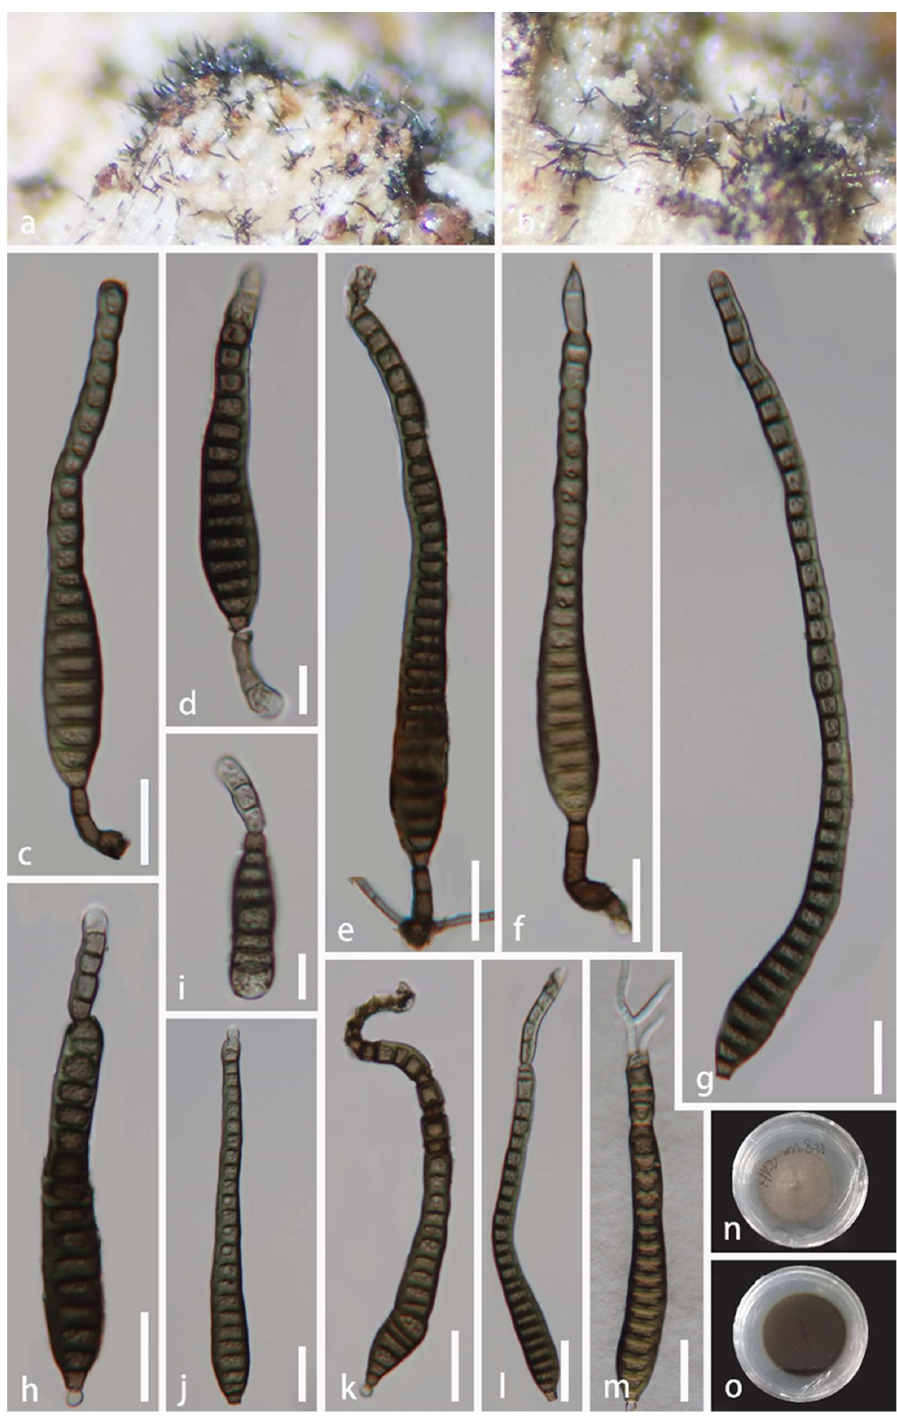
Figure 5. Distoseptispora pachyconidia (HKAS 123754). ( a , b ) Colonies on the host surface. ( c – f ) Conidiophores and conidiogenous cells bearing conidia. ( g – l ) Conidia. ( m ) Germinating conidium. ( n , o ) Colonies on PDA, n from above, o from reverse. Scale bars: ( c,e – h , j – m ) 20 μm, ( d , i ) 10 μm. Distoseptispora septata J. Ma and Y.Z. Lu, sp. nov., Figure 6. Index Fungorum number: IF559688; Facesoffungi number: FoF11337. Etymology: ‘ septata ’ referring to ‘septate’ conidia.